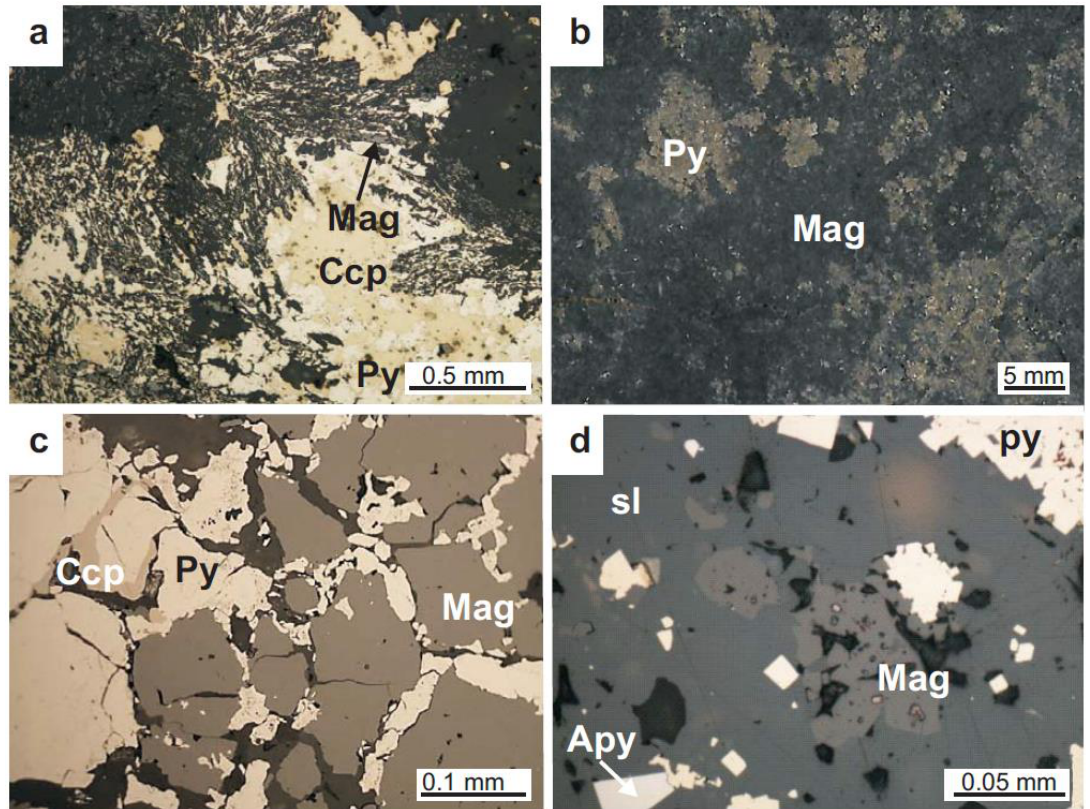
Figure 3. Optical microscope images of magnetite mineralization from several massive sulfide deposits of the IPB. ( a ) Relicts of radial magnetite (Mag) aggregates partially replaced by pyrite (Py). Chalcopyrite filling interstices in pyrite aggregates is also observed; ( b ) massive magnetite partially replaced by xenomorphic pyritic aggregates; ( c ) magnetite showing mosaic texture partially replaced by pyrite along intergranular spaces. In addition, pyrite is replaced by chalcopyrite; ( d ) subidiomorphic magnetite crystals partially corroded and embedded in sphalerite (Sp). Sphalerite is associated with idiomorphic pyrite and arsenopyrite (Apy) grains. Aguas Teñidas deposit ( a , c ); Magdalena deposit ( b ); San Miguel deposit ( d ).